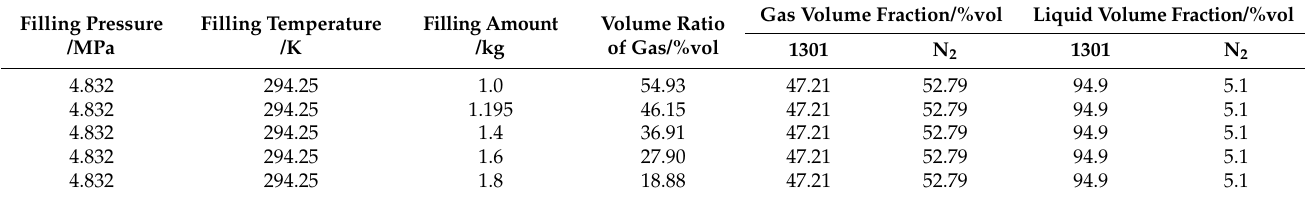
Table 2. Initial state of the extinguishing bottle under different filling